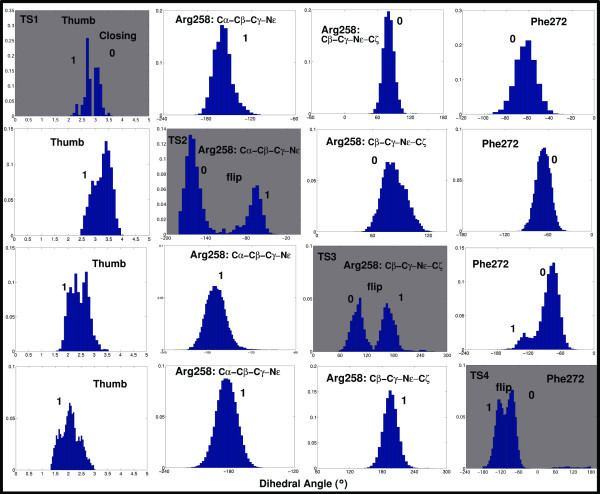
Order parameter distributions in the 8-oxoG:dCTP system. Normalized probability distributions of the order parameters in TS1 to TS4 in the 8-oxoG:dCTP complex. Labels 0 and 1 indicate the open and closed states of the residues and thumb subdomain.